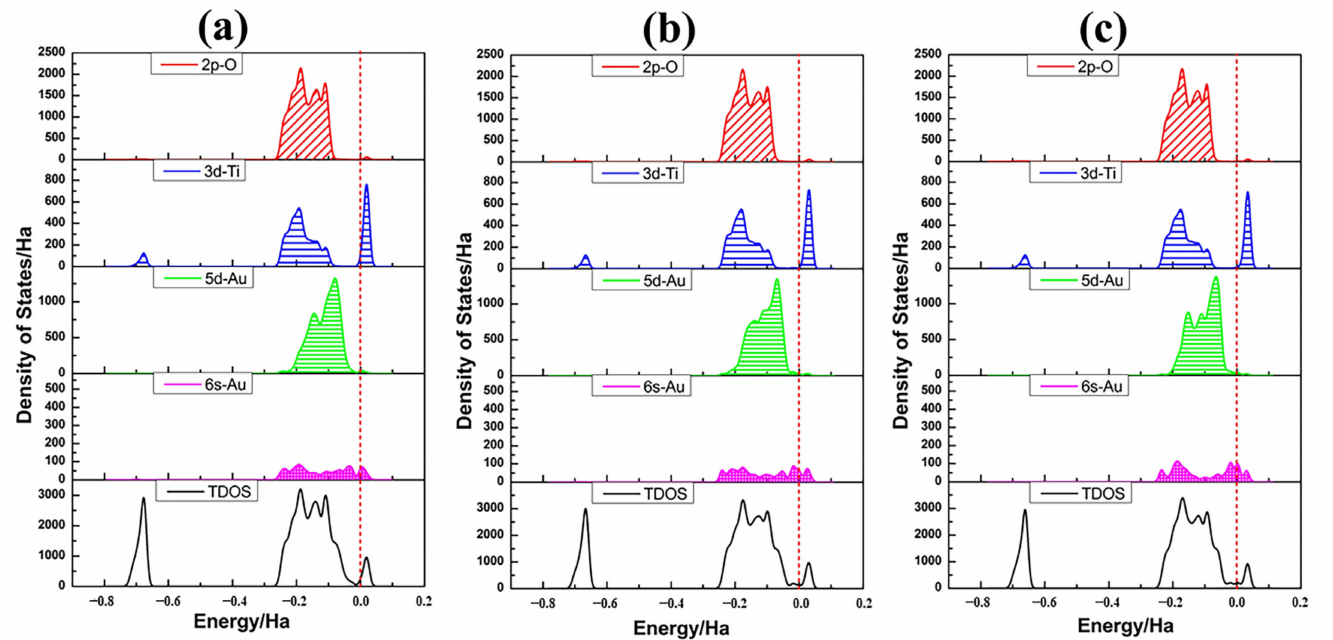
Figure 10. Density of state profiles and the partial density of states of Au 13 and relevant nan- otube surface atoms for Au 13 clusters in four different adsorption states: ( a ) Au 13-A(2cO,2cO) ,